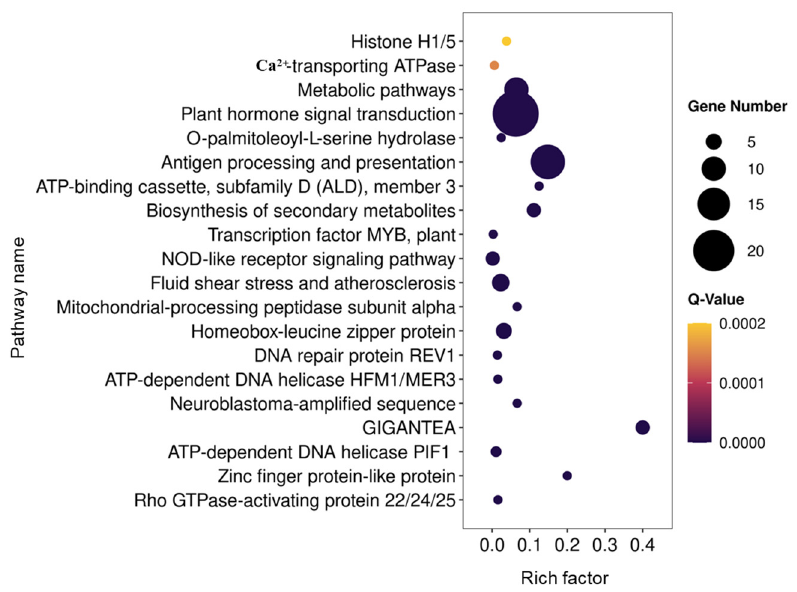
Figure 7. Kyoto Encyclopedia of Genes and Genomes (KEGG) enrichment analysis for target genes of differently expressed miRNAs in ZL and FS in response to Al stress.